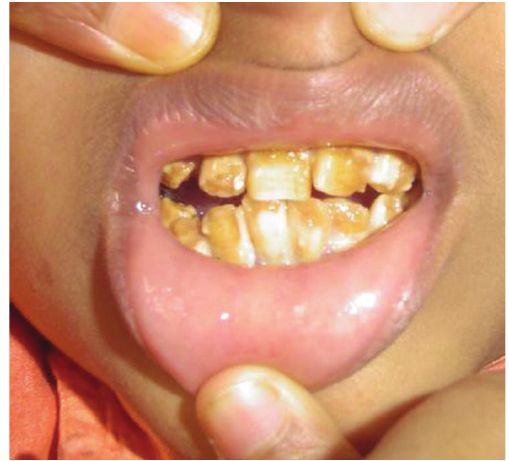
Figure 5: Intraoral photograph of the elder sibling showing yellow- ish discolouration of the dentition.